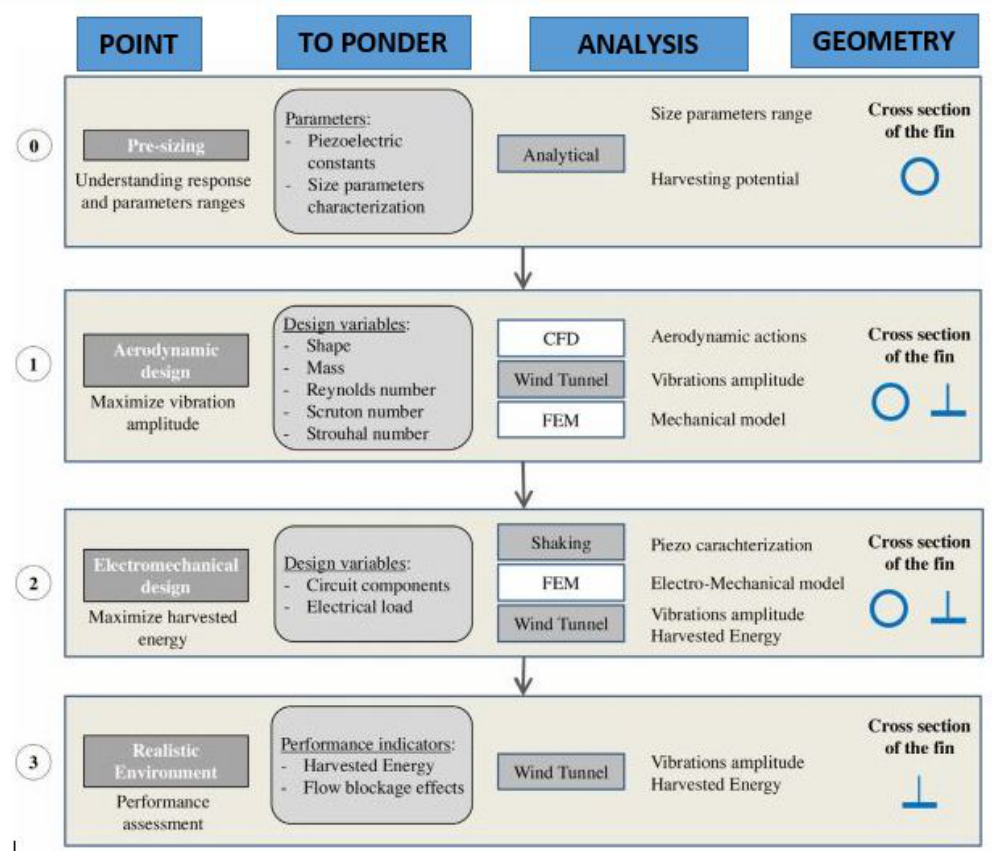
Figure 14. Design steps for PEH